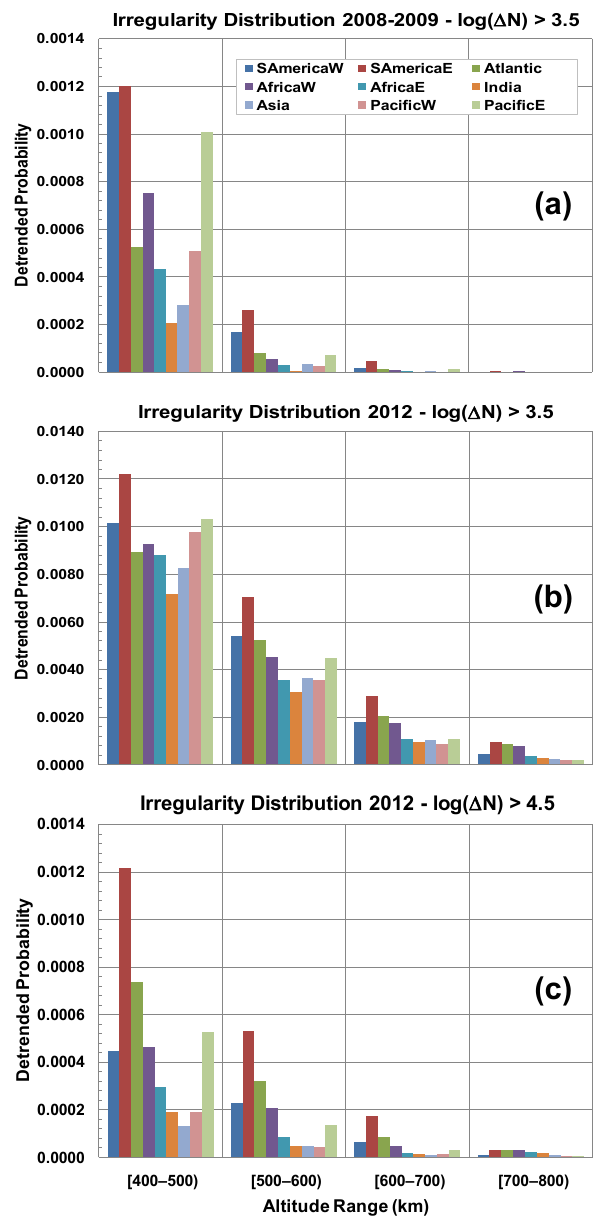
Figure 7. Detrended probability distributions of 1N i as functions of altitude ranges and longitude sectors for (a) 2008–2009 and log (1N i ) > 3 . 5, (b) 2012 and log (1N i ) > 3 . 5, and (c) 2012 and log (1N i ) > 4 . 5. The smallest probabilities that meet the criteria for statistical significance are associated with the African East longitude sector and the altitude range [600–700km) in (a) and the African East longitude sector and the altitude range [600–700km) in (c) , respectively.